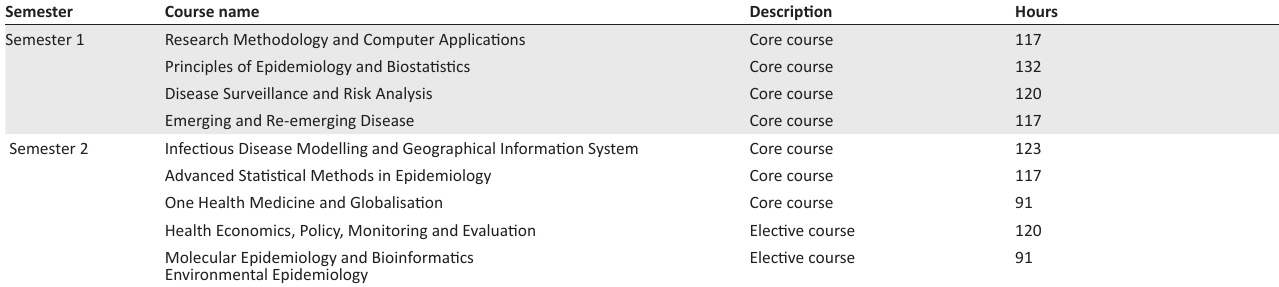
TABLE 1: Programme structure for the One Health Analytical Epidemiology and distribution of courses by semester.